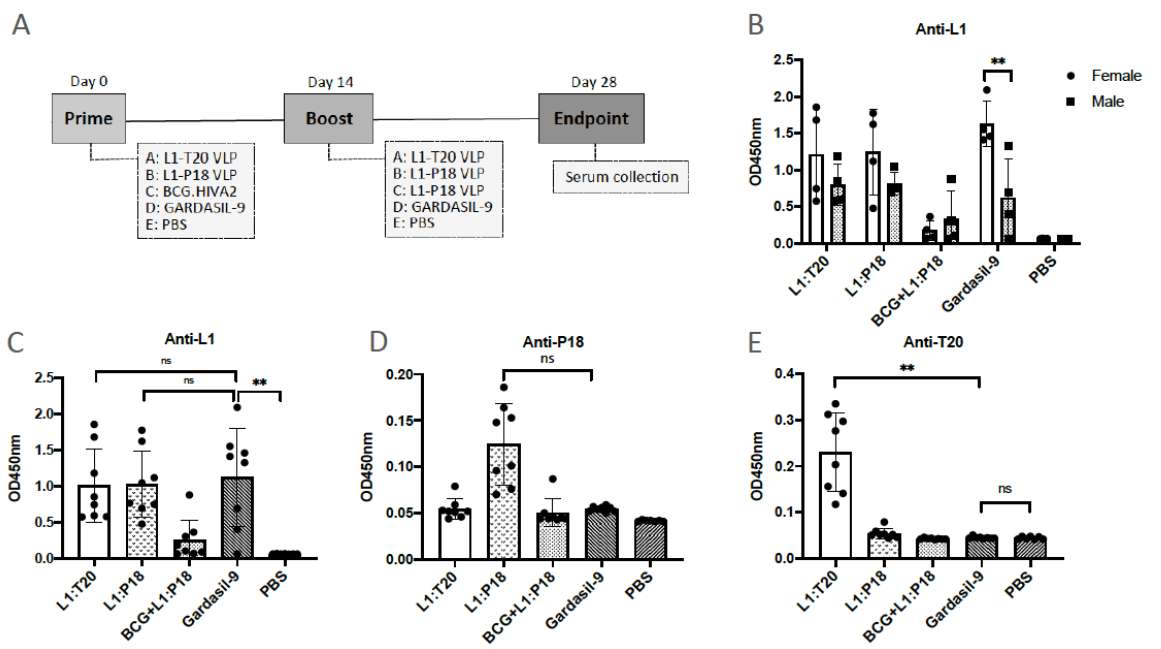
Figure 6 . Induction of humoral immune responses by L1:P18I10 and L1:T20 VLPs in BALB/c mice. The immunization schedule is depicted in ( A ) All mouse groups had equal gender distribution (male n = 4 and female n = 4). Groups A and B: homologous prime-boost immunization with 10 µ g L1:P18I10 or L1:T20 VLPs intramuscularly (i.m.); Group C: priming with 10 6 cfu rBCG.HIVA intradermally (i.d.) and boosting with 10 µ g L1:P18I10 VLPs i.m.; Group D: homologous prime-boost vaccination with Gardasil-9 containing 10 µ g of HPV16 L1 VLPs i.m.; Group E: immunization twice with PBS buffer. The prime-boost interval was 2 weeks. The end point of this trial was on day 28. Sera were collected and diluted at a titer of 1:50 for ELISA assay. ( B ) HPV L1-specific IgG in male and female mice. ( C – E ) Epitope-specific IgG induced by L1:P18I10 and L1:T20 VLPs. ELISA was performed to analyze anti-L1, anti-P18I10 and anti-T20 IgG induced by BALB/c mice following different prime-boost combinations as described above. Data are shown as mean ± S.D. One-way ANOVA (nonparametric) test was done to compare differences between groups. OD: opticaldensity. Ns not significant; ** p <